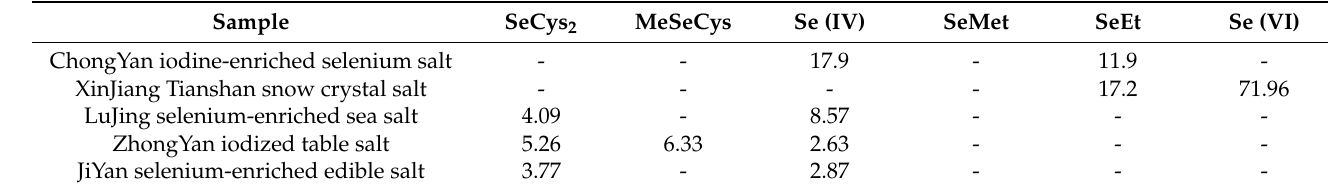
Table 3. Selenium speciation in selenium-enriched salt ( µ g kg − 1 ).